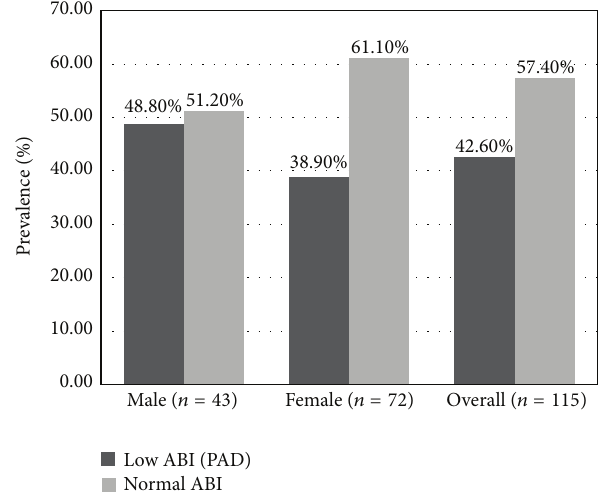
Figure 1: Overall, and by gender prevalence of PAD in adults aged 40 years and older. General Hospital of Huambo, Angola, 2015 ( 𝑛 = 115